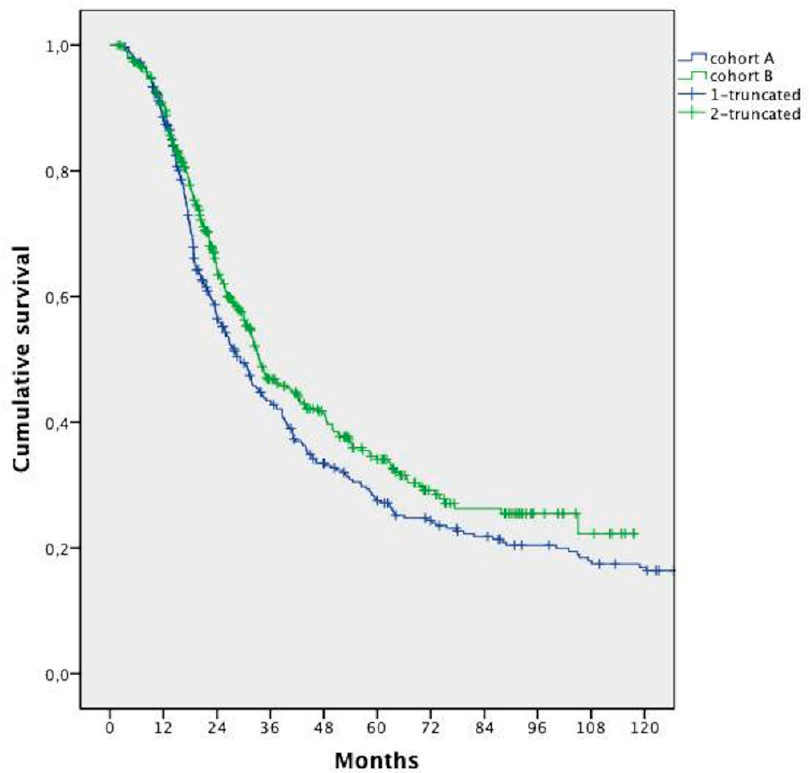
Figure 1. Median overall survival analysis in the two cohorts.